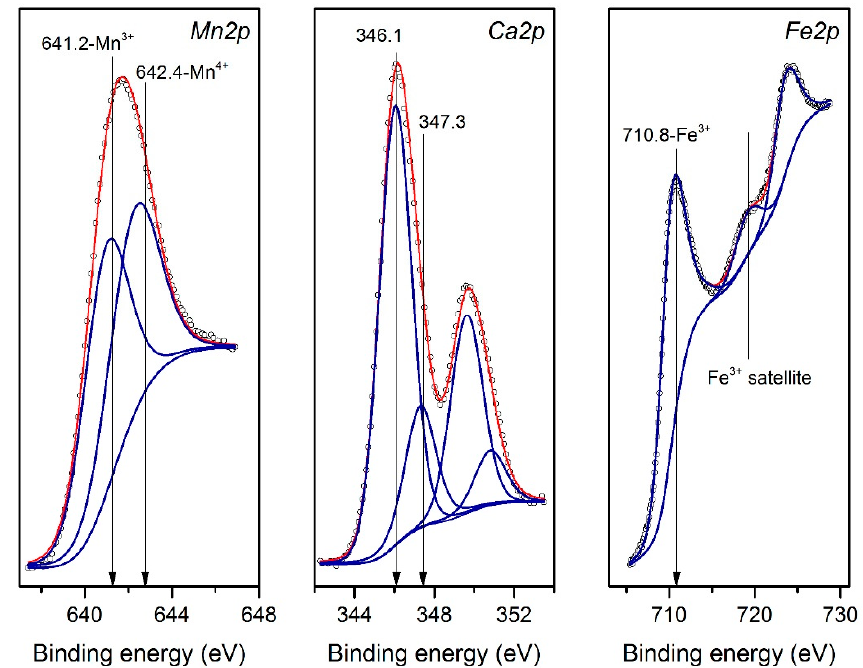
Figure 3. XPS spectra of the fresh sample La 0.5 Ca 0.5 Mn 0.5 Fe 0.5 O 3 with line deconvolution.